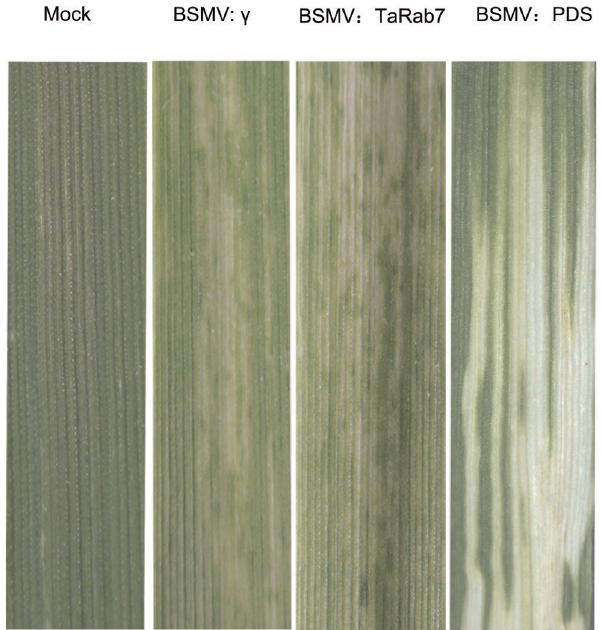
Figure 6. Mild chlorotic mosaic symptoms were observed on the leaves at 9 dpi. Mild chlorotic mosaic symptoms were observed on the leaves inoculated with BSMV: c or BSMV:TaRab7 at 9 dpi. Photobleaching was evident on leaves infected with BSMV: TaPDS at 15 dpi but not on mock-inoculated leaves.